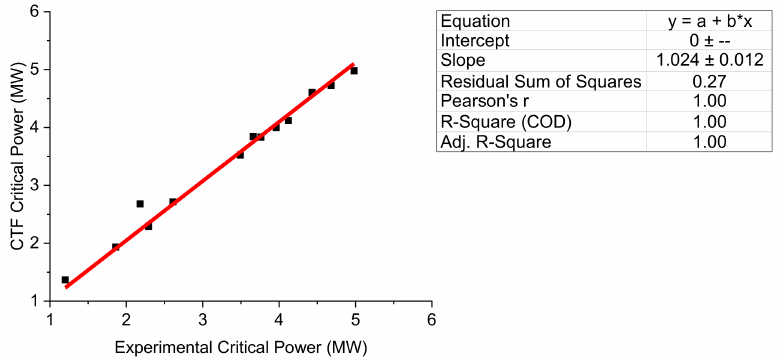
Figure 9. CTF vs. experimental critical-heat